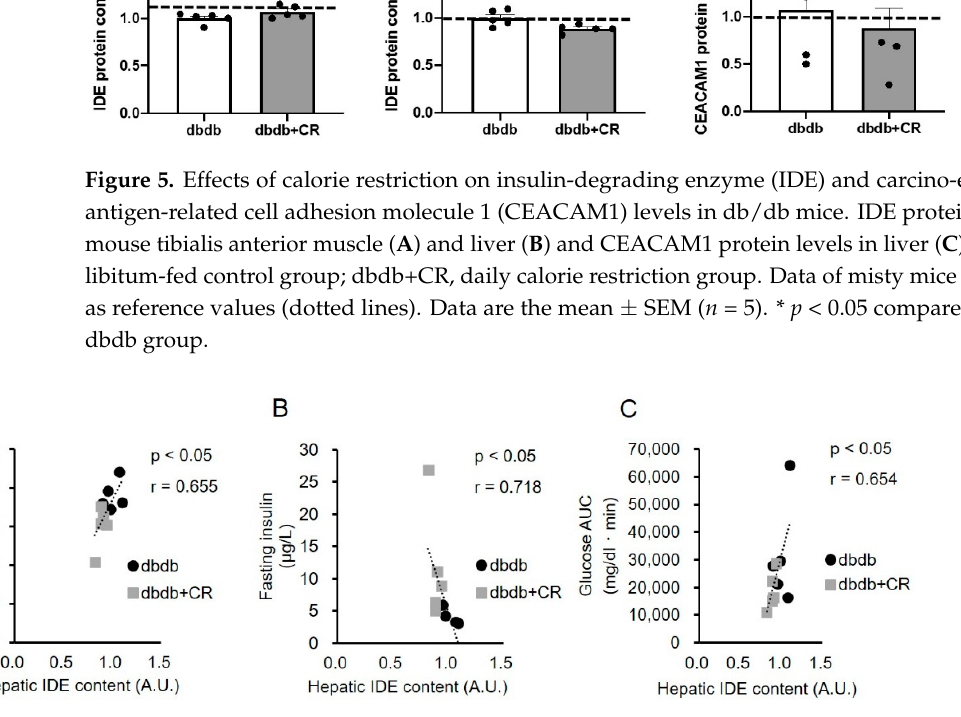
Figure 6. Correlations between hepatic insulin-degrading enzyme (IDE) levels and fasting glucose ( A ) or fasting insulin ( B ) concentrations or glucose area under the curve (AUC) during the oral glucose tolerance test (OGTT) ( C ). dbdb, ad libitum-fed control group; dbdb+CR, daily calorie restriction group.